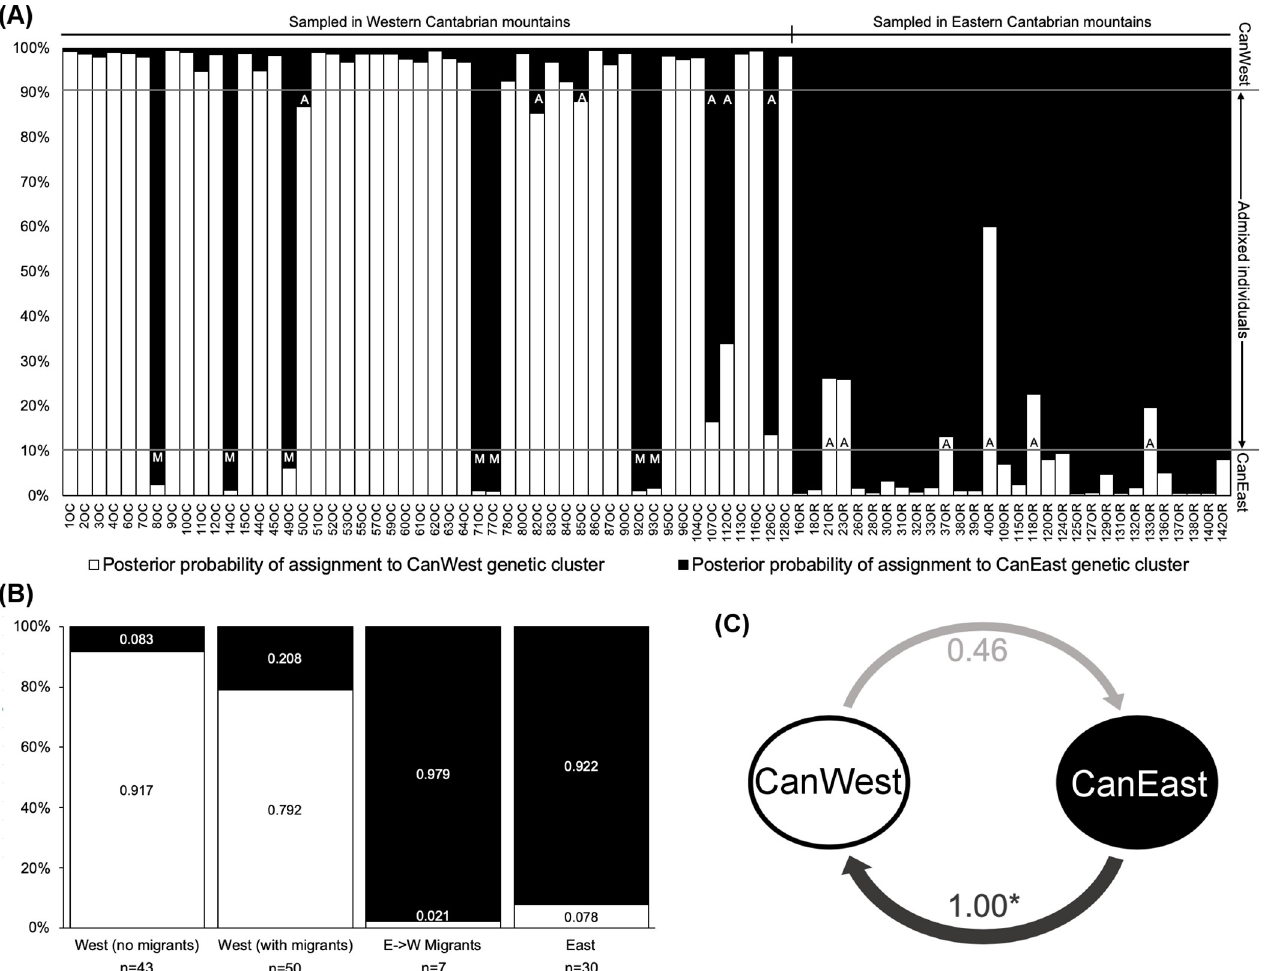
Fig 3. Genetic assignment, admixture and gene flow among brown bear subpopulations in the Cantabrian Mountains. (a) Posterior probability of assignment of individual genotypes to each of the genetic clusters matching the two subpopulations. Thresholds of assignment to the CanWest and CanEast genetic clusters are represented as horizontal lines. Admixed individuals (denoted “A”) have intermediate assignment posterior probabilities. First generation migrants (denoted “M”) were assigned with higher posterior probability to the subpopulation other than that from which they were sampled. (b) Average posterior probabilities of assignment to each genetic cluster per subpopulation, and for the Western Cantabrian subpopulation without migrants, or for first generation migrants alone. (c) Relative migration flows (in number of migrants, Nm). Significantly asymmetric migration flow is marked with an